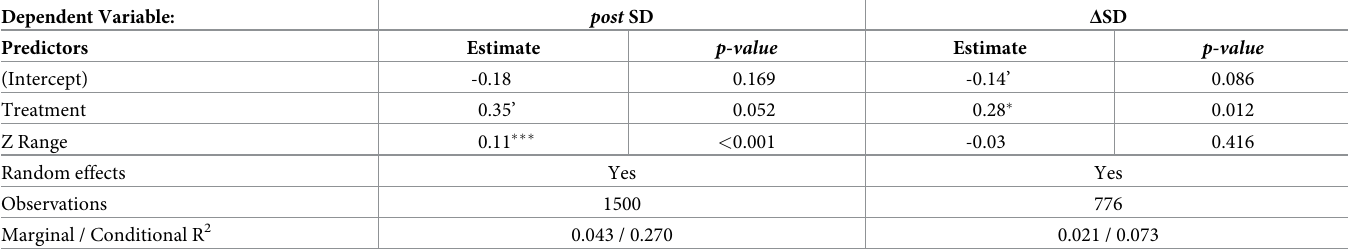
Table 1. Mixed models for team polarization. The presence of the VAE bot in hybrid teams increased the likelihood of polarization and the spread of forecasts post social